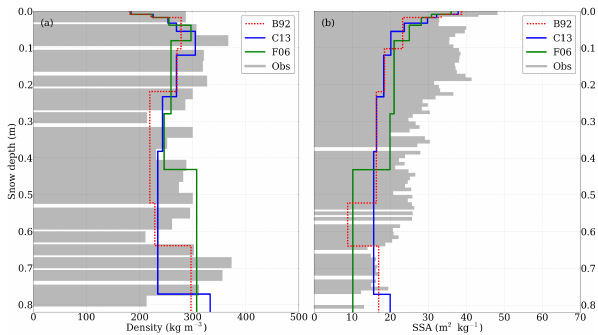
Fig. 8: Comparison between simulated and measured density (left) and SSA (right) at Summit, on Fig. 8. Comparison between simulated and measured density (left) 10May2011,12h00LT. and SSA (right) at Summit, on 10 May 2011,